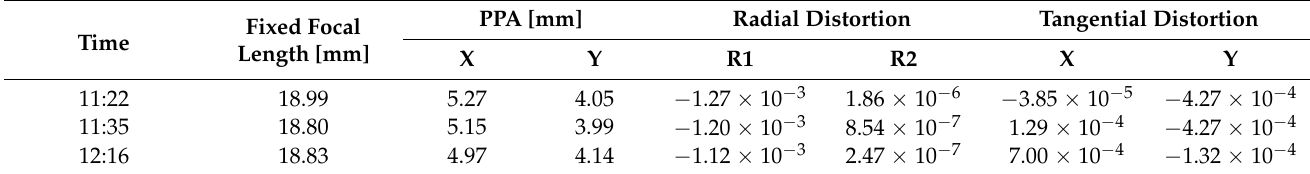
Table A6. Results of geometric calibration for three measurement series for thresholding.